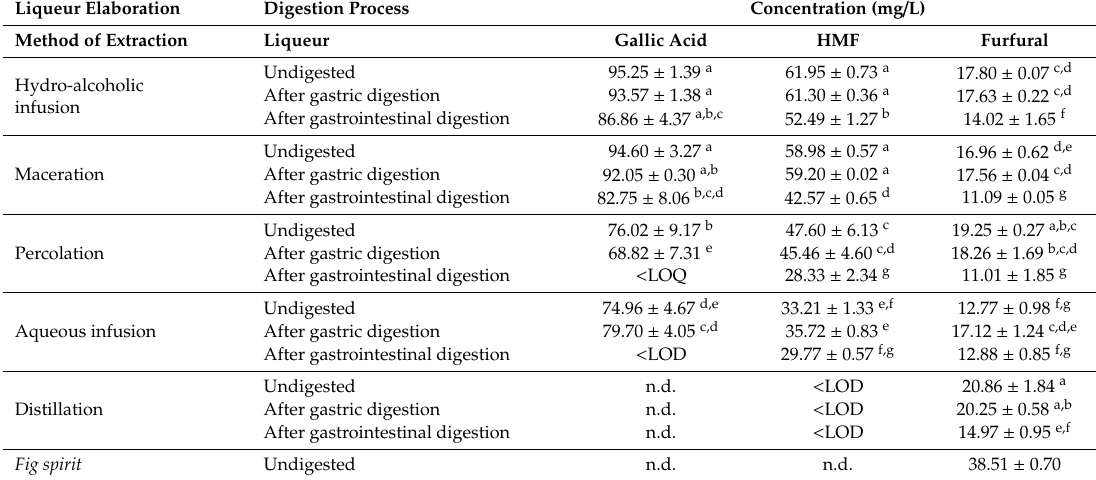
Fig spirit Undigested n.d. n.d. 38.51 ± 0.70 Values are expressed as mean ± standard deviation ( n = 3). In the same column, values marked with di ff erent letters indicate a significant di ff erence ( p < 0.05). LOQ: limit of quantification; LOD: limit of detection; n.d.: not detected. HMF: 5-hydroxymethyl